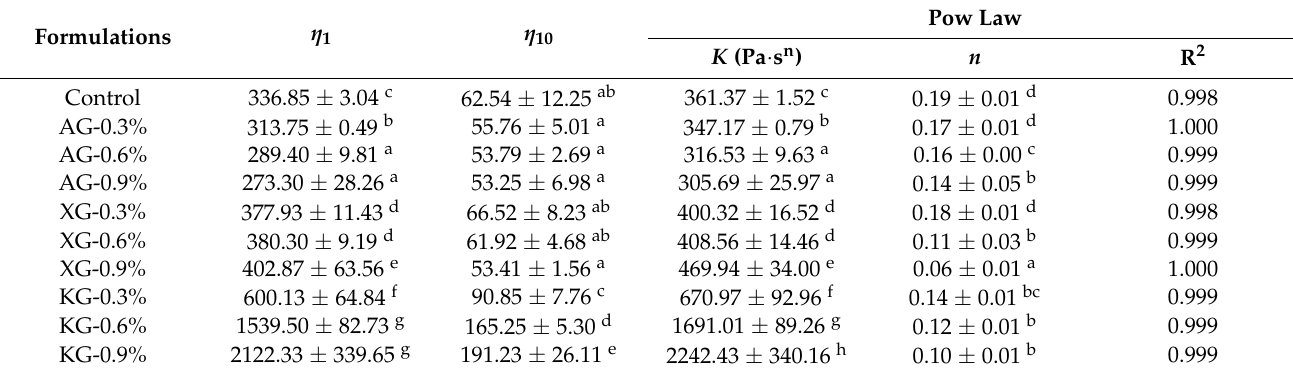
Table 2. Viscosities at the shear rates of 1 s − 1 ( η 1 ) and 10 s − 1 ( η 10 ), and power-law fitted parameters of ink samples.